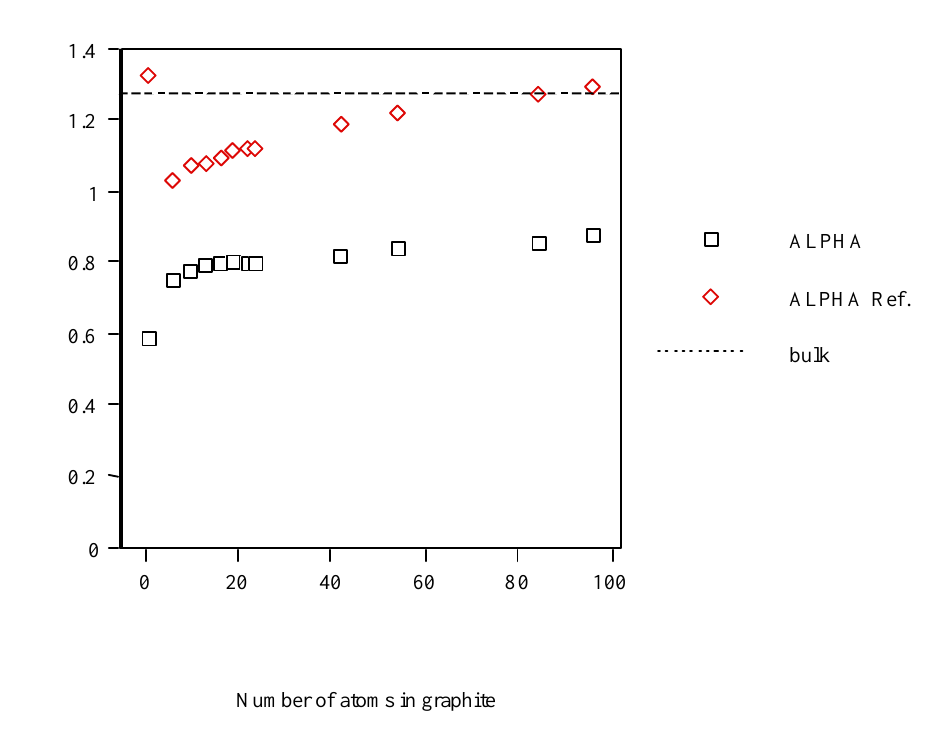
Figure 3. Average atom-atom polarizabilities per atom of one-shell graphite models vs . cluster